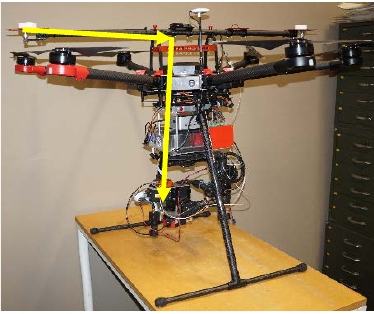
Figure 3 – Matrice 600 airframe with sensor payload, yellow lines indicate the lever arm correction